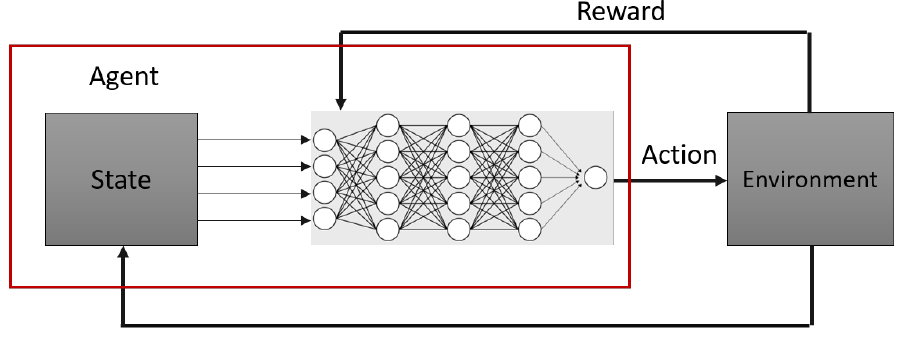
Figure 5. Principles of